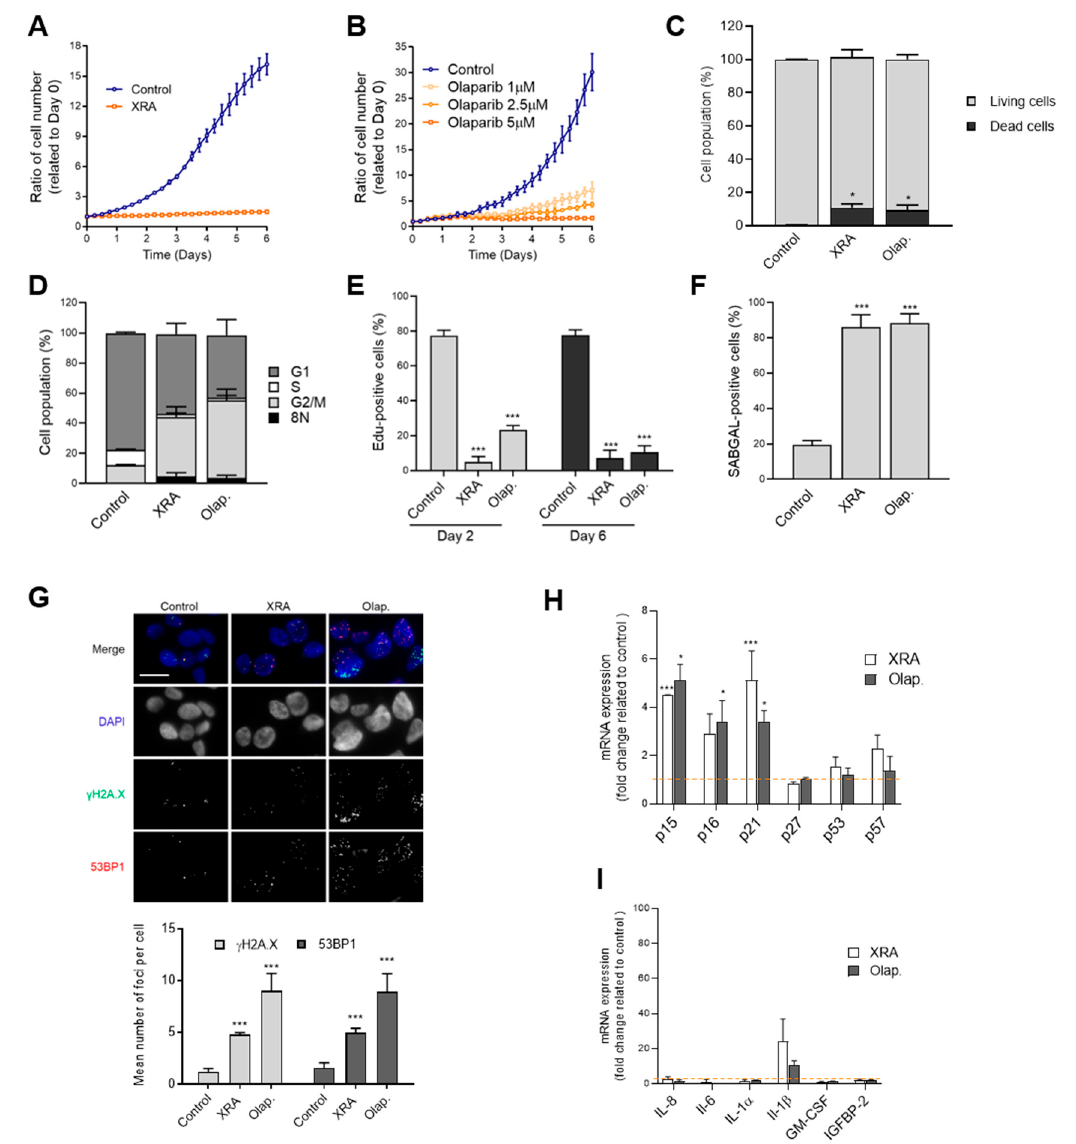
Figure 1. Therapy-induced DNA damage triggers senescence in LNCaP cells. ( A , B ) Cell proliferation curves of LNCaP expressing H2B-GFP and ( A ) irradiated with 8 Gy of X-Rays (XRA) or ( B ) treated with increasing concentrations of olaparib (Olap). Data are the mean ± SD of triplicate and are representatives of three independent experiments. (CI) LNCaP cells were irradiated with 8 Gy XRA or treated with 5 µ M Olap. ( C ) The cumulative cell death of LNCaP was analyzed by flow cytometry 6 days after XRA or Olap treatment. ( D ) Flow cytometry analysis of cell cycle populations following 6 days of exposure of LNCaP cells to XRA or Olap. ( E ) Cell proliferation was assessed by incorporation of EdU for 24 h at 1 or 5 days after XRA or Olap treatment. ( F ) SA- β -gal assay was performed on LNCaP cells 6 days after XRA or Olap treatment. ( G ) Representative images (top) and quantifications (bottom) of γ H2AX (green) and 53BP1 (red) foci per nucleus in LNCaP cells 6 days following XRA or Olap treatment. The merged red and green channels show colocalization in yellow and DAPI is shown in blue. Scale bar = 20 µ M ( H , I ) Relative mRNA levels of ( H ) CDKi or ( I ) SASP factors were evaluated by real-time Q-PCR in LNCaP cells irradiated or treated with Olap for 6 days. The values represent the fold change expression related to non-treated controls (represented by the dashed line). ( C – I ) The mean ± SD of three independent experiments is shown. Statistical analysis: ( C , E , F , G ) two-tailed Student’s t -test; ( H , I ) two-way ANOVA. * p < 0.05, *** p < 0.001.